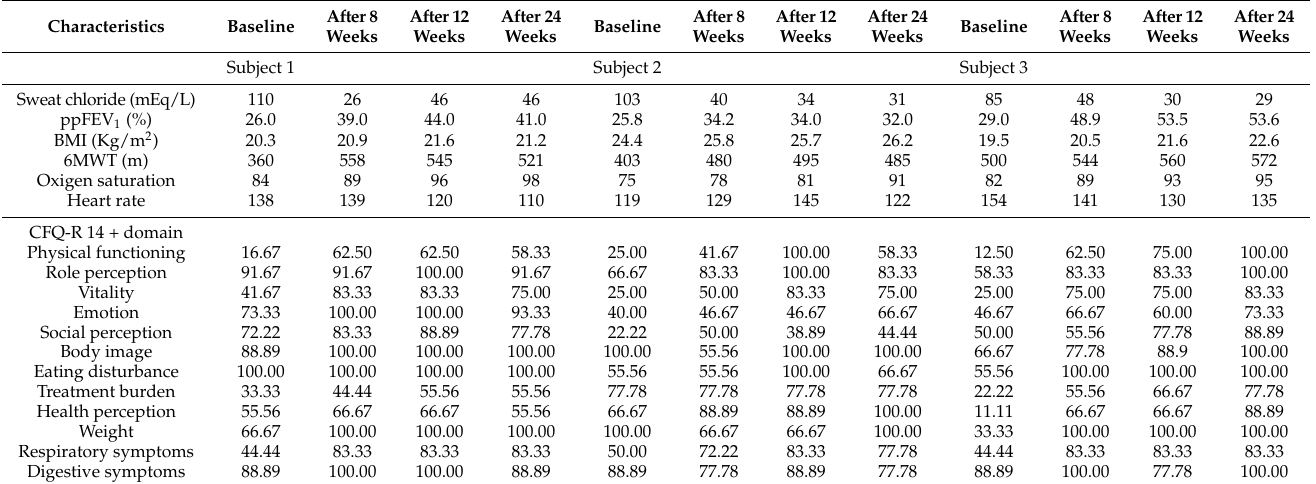
Table 1. Comparison of change in all variables over the treatment